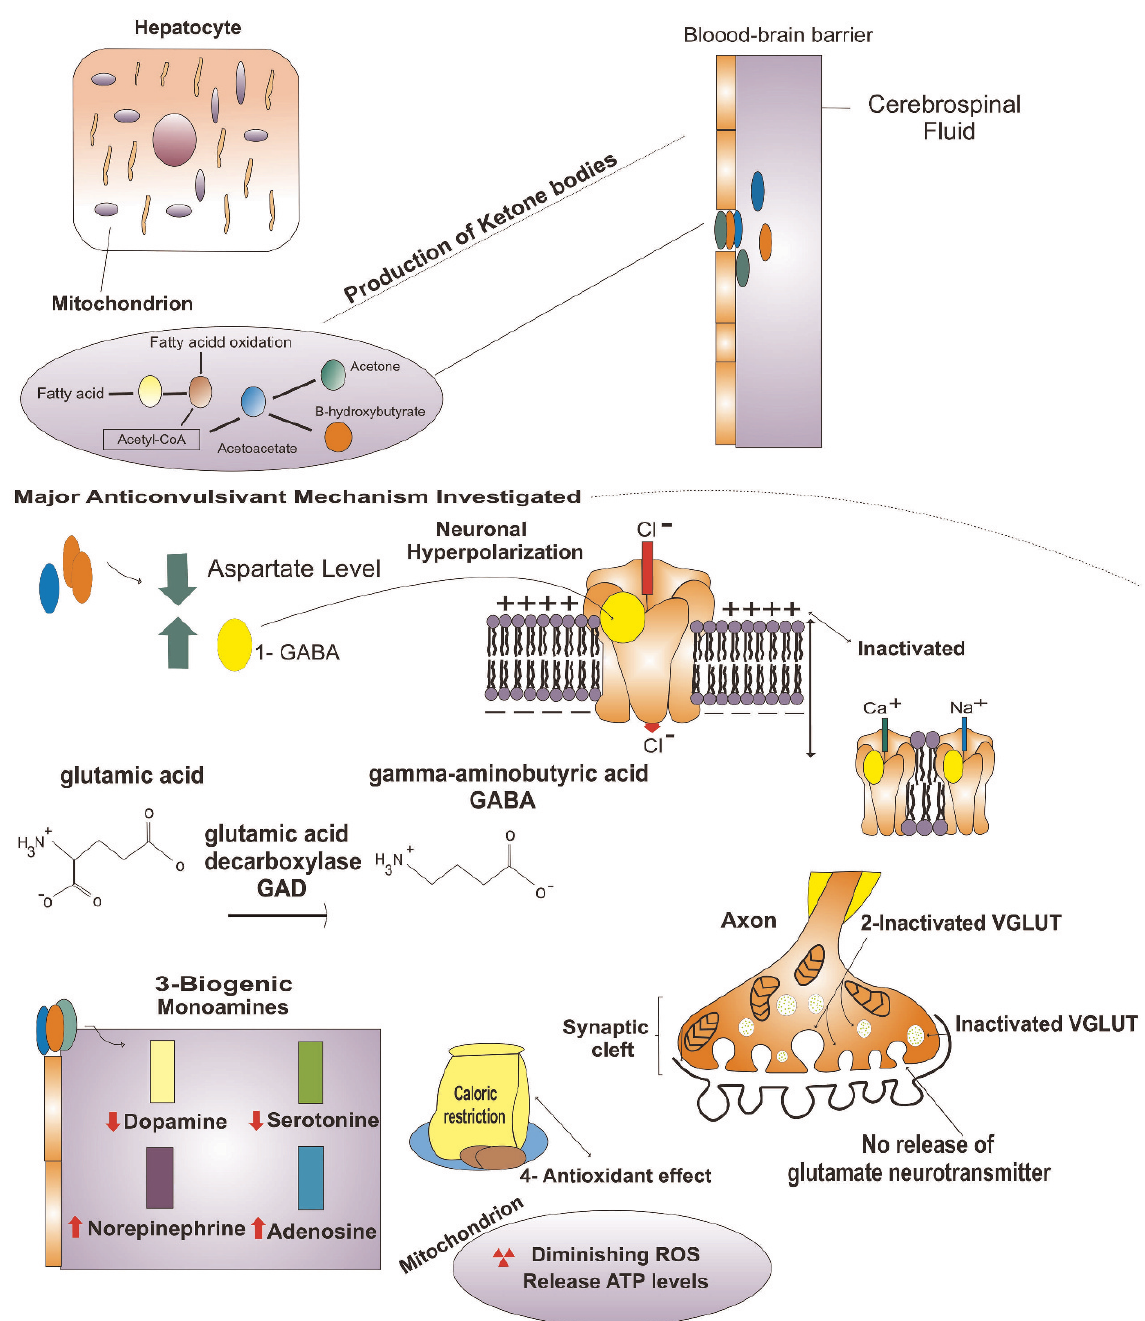
Figure 1 - Production of ketone bodies and potential primary anticonvulsant mechanisms: (1) GABA neurotransmitter (neuronal hyperpolarization and membrane channels; (2) inactivation of VGLUT and inhibition of glutamate neurotransmitter; (3) modified concentrations of biogenic monoamines; and (4) antioxidant mechanism of diminishing reactive oxygen species. For more information, please